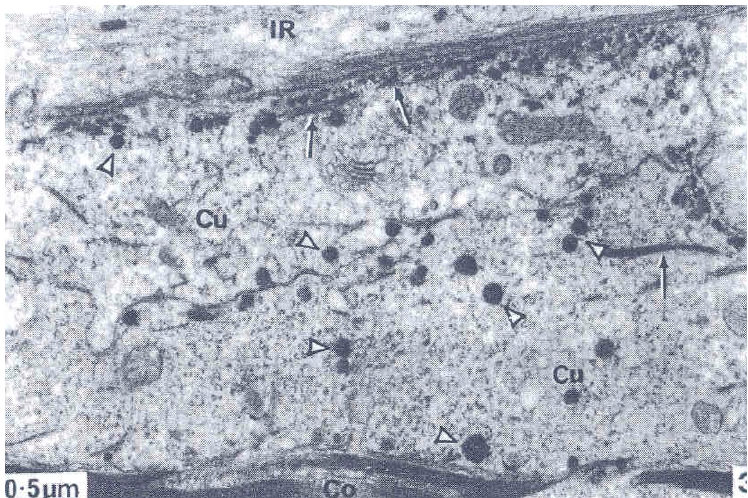
Figure 3. Early stage f formation of A-layer and exocuticle showing type 1 droplets migrated to cell membrane and mixed with filaments (black arrow). The larger Type 2 droplets nearby are in the cytoplasm (arrowheads). From reference [4].